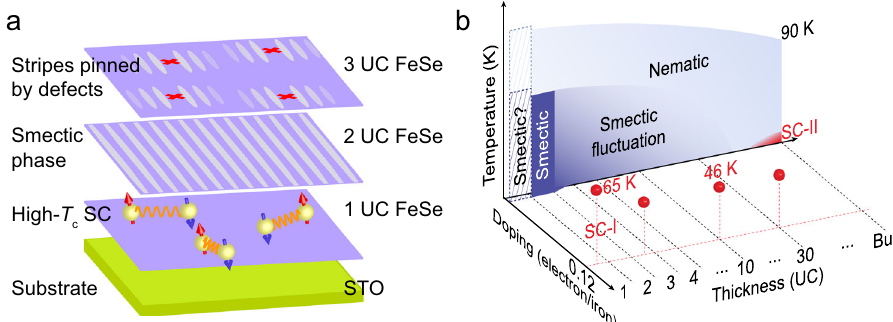
Fig. 5 Phase diagram of FeSe/STO. a Schematic of electronic structures in different layers of FeSe. The 1 UC FeSe/STO is a high- T c superconductor. Smectic phase with long-range stripe ordering is established in 2 UC FeSe fi lms. 3 UC FeSe is in nematic phase with strong smectic fl uctuation. Short-range stripes are pinned by defects. b Phase diagram of FeSe/STO as a function of temperature, thickness, and electron doping. The smectic phase may persist in 1 UC FeSe/STO once the electron doping is partially removed. In reality, by a large amount of electron doping from STO (0.12 electron/Fe), smectic phase is suppressed and high- T c superconductivity (SC-I) emerges in 1 UC FeSe, in which the residual smectic instability provides additional T c enhancement. In multilayer FeSe/STO, the superconducting states can be achieved by surface doping of alkali metals. The red balls denote the optimal T c obtained from ARPES results